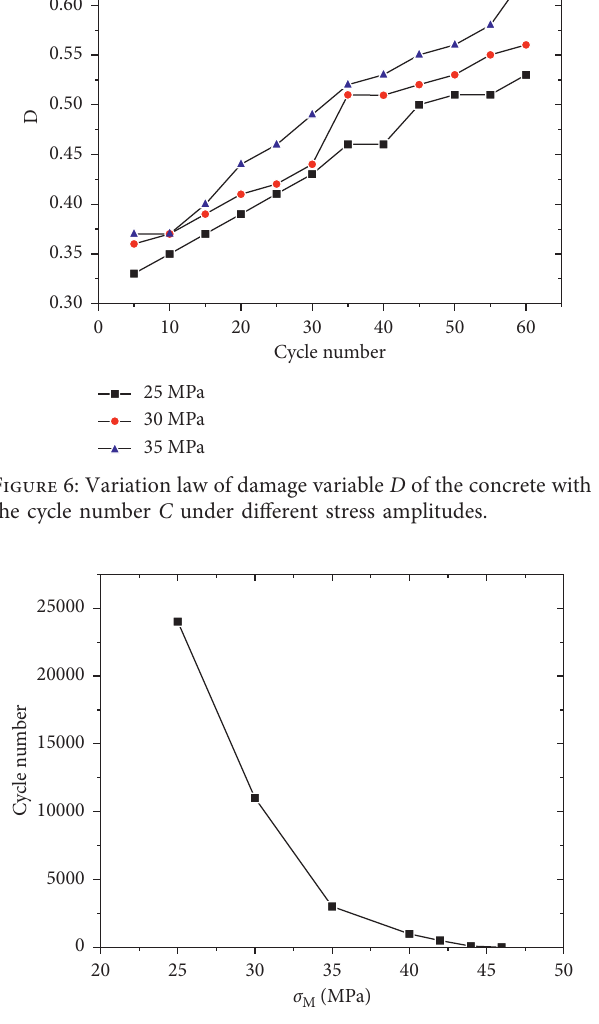
Figure 7: Relation law between cyclic number C and stress amplitude σ M of